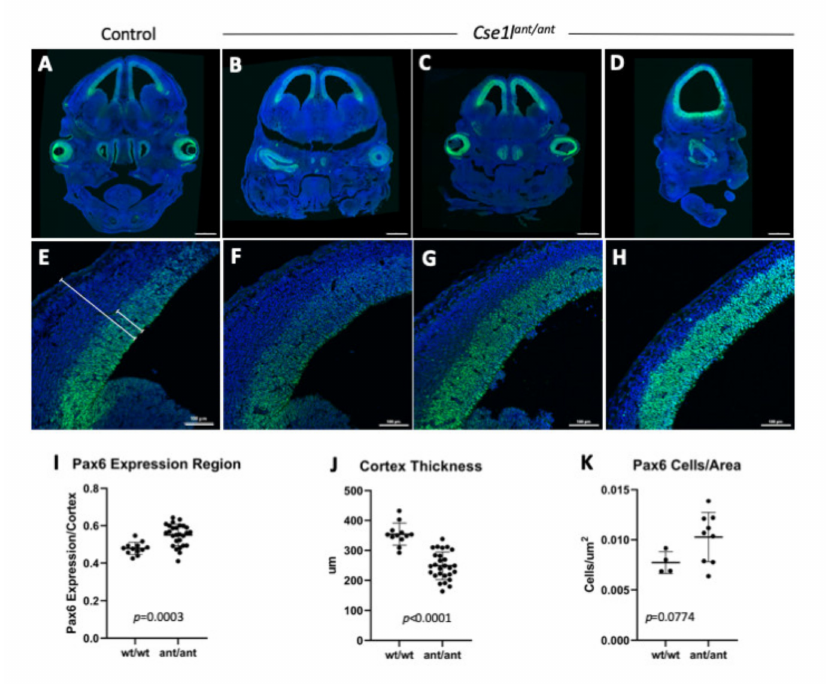
Figure 8. Cse1l is required for wild-type PAX6 expression in the brain. Cse1l ant/ant mutants as compared to Cse1l wt/wt ( A,E ) show an increase in the domain of PAX6 expression in the E14.5 cortex ( B – D , F – I ), as well as a decrease in cortical thickness ( J ). These combine for a higher density of PAX6- positive cells in the mutant cortex ( K ). Lines in E indicate the areas measured for cortical thickness (longer) and the PAX6 expression quantified and shown in ( I , J